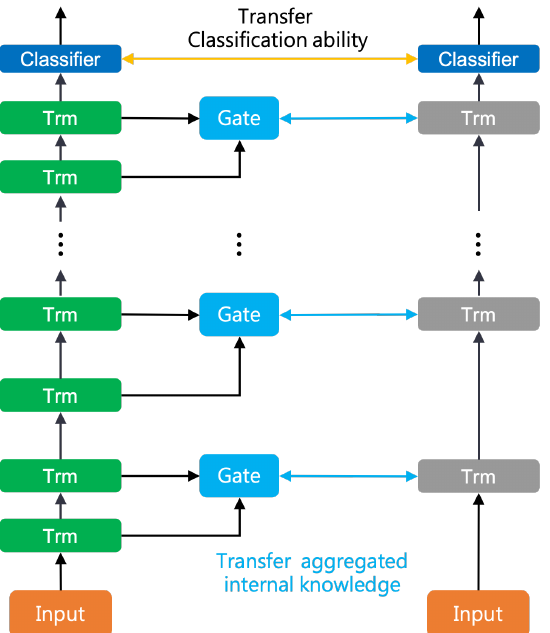
Figure 2. The model structure of LAD-NO. The left shows the teacher model, and the right indicates the student